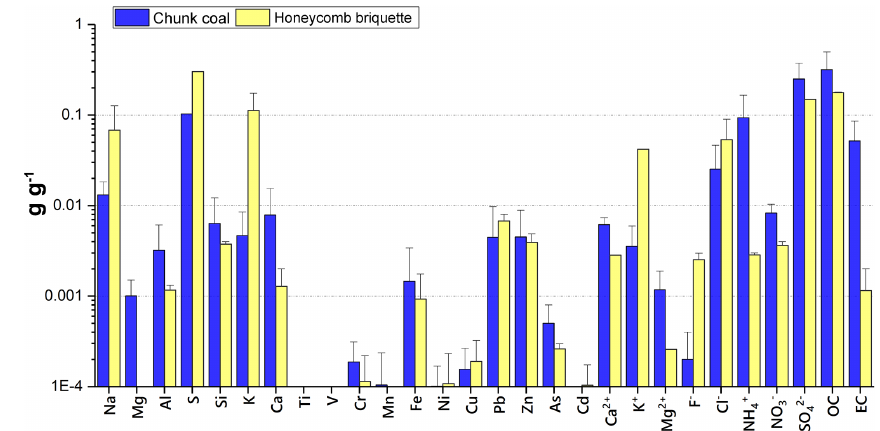
Figure 7. RCC profiles of PM 2 . 5 emissions from chunk coal and honeycomb briquette coals. Data were collated from published data (Ge